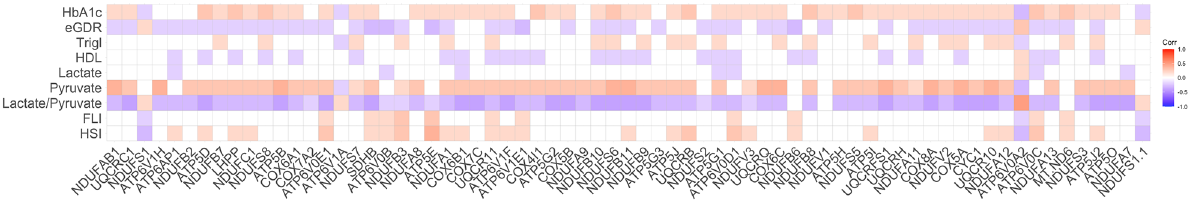
Figure 5. Correlations between differentially expressed OXPHOS genes (x-axis) and metabolic parameters